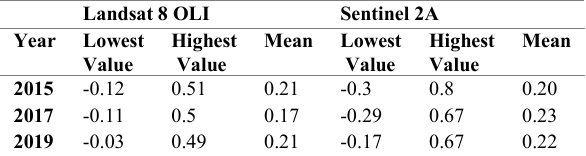
Table 5: NDVI Value Ranges for Landsat 8 and Sentinel 2A 3.4 Comparative Analysis of Landsat 8 OLI and Sentinel